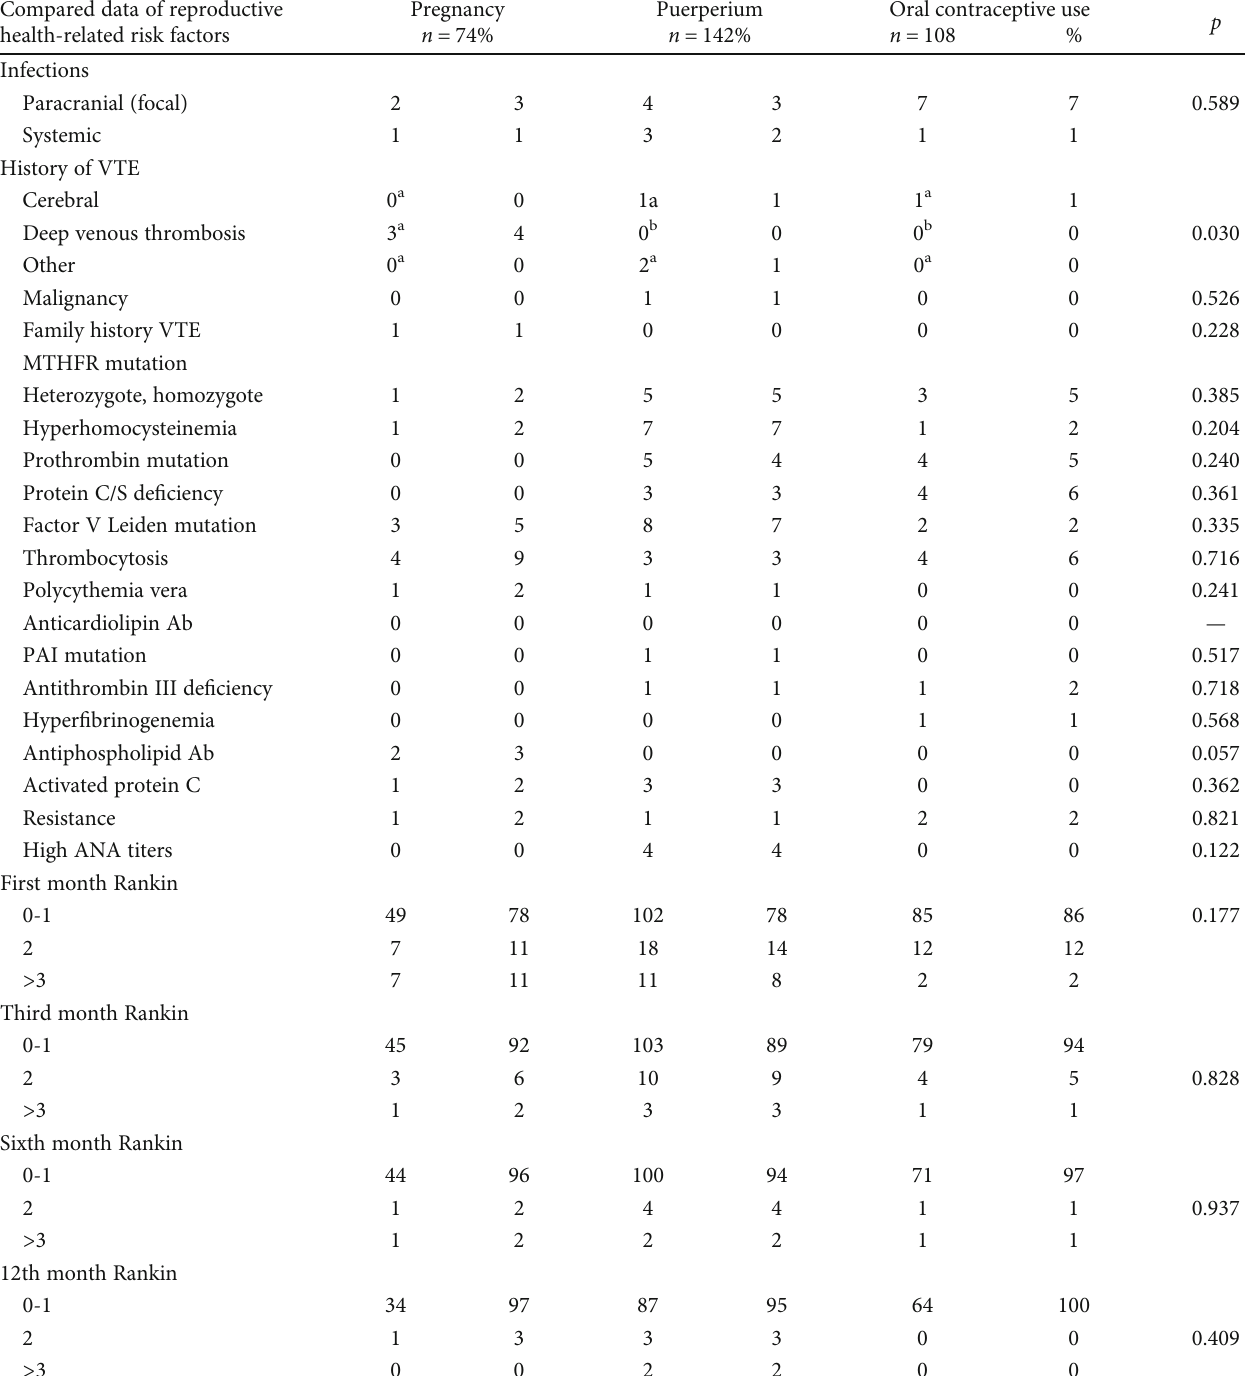
Table 4: Etiological factors and outcome of subgroups according to reproductive health-related